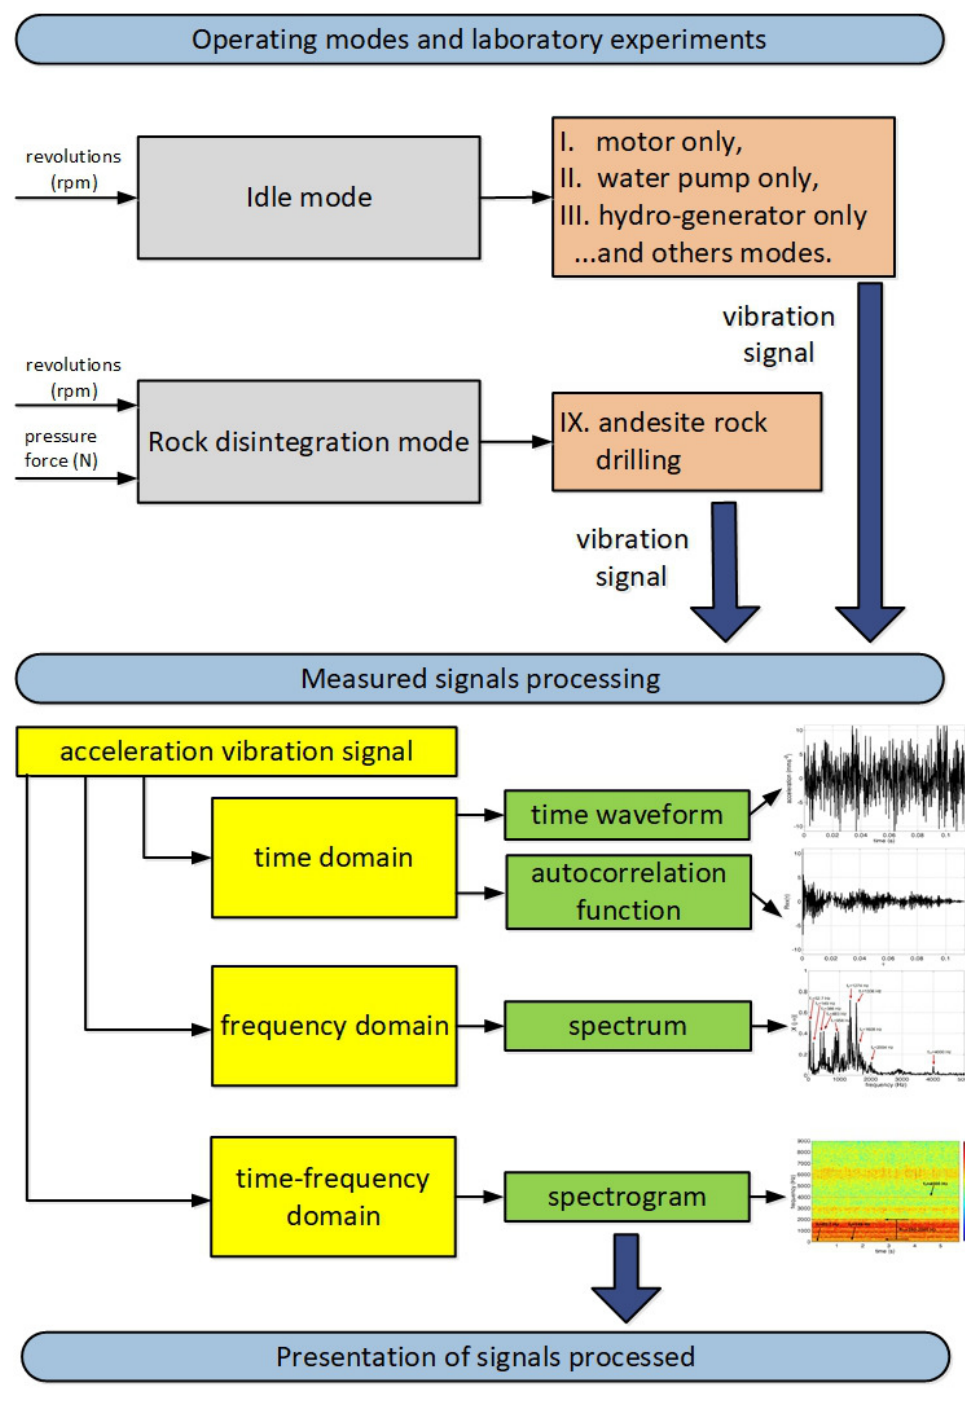
Figure 1. Experiments